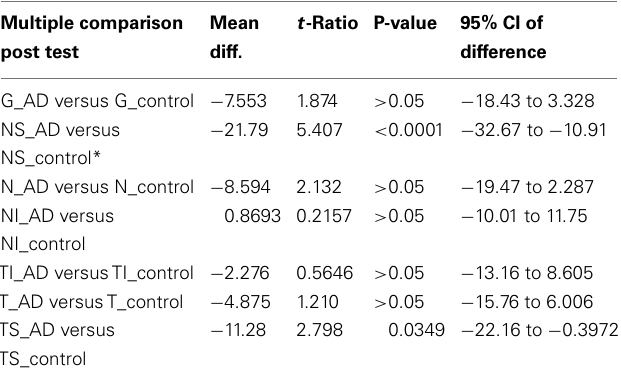
Table 1 | Comparison of the different sectors around the optic disk regarding the retinal nerve fiber layer thickness.